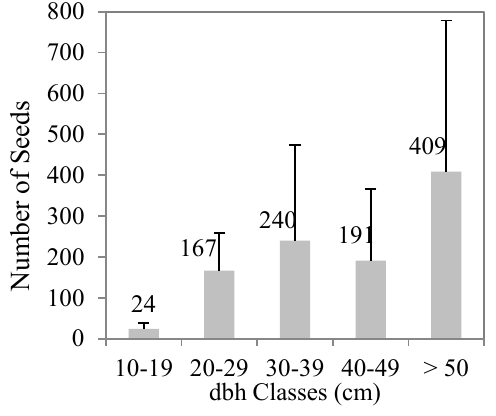
Figure 3. Mean production of seeds of Carapa according to dbh